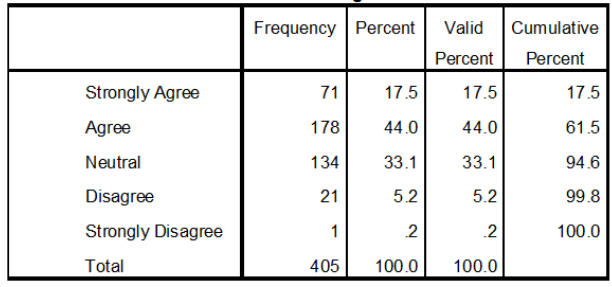
Figure 47. Our customers are readily willing to try all our new cloud and IoT based offerings